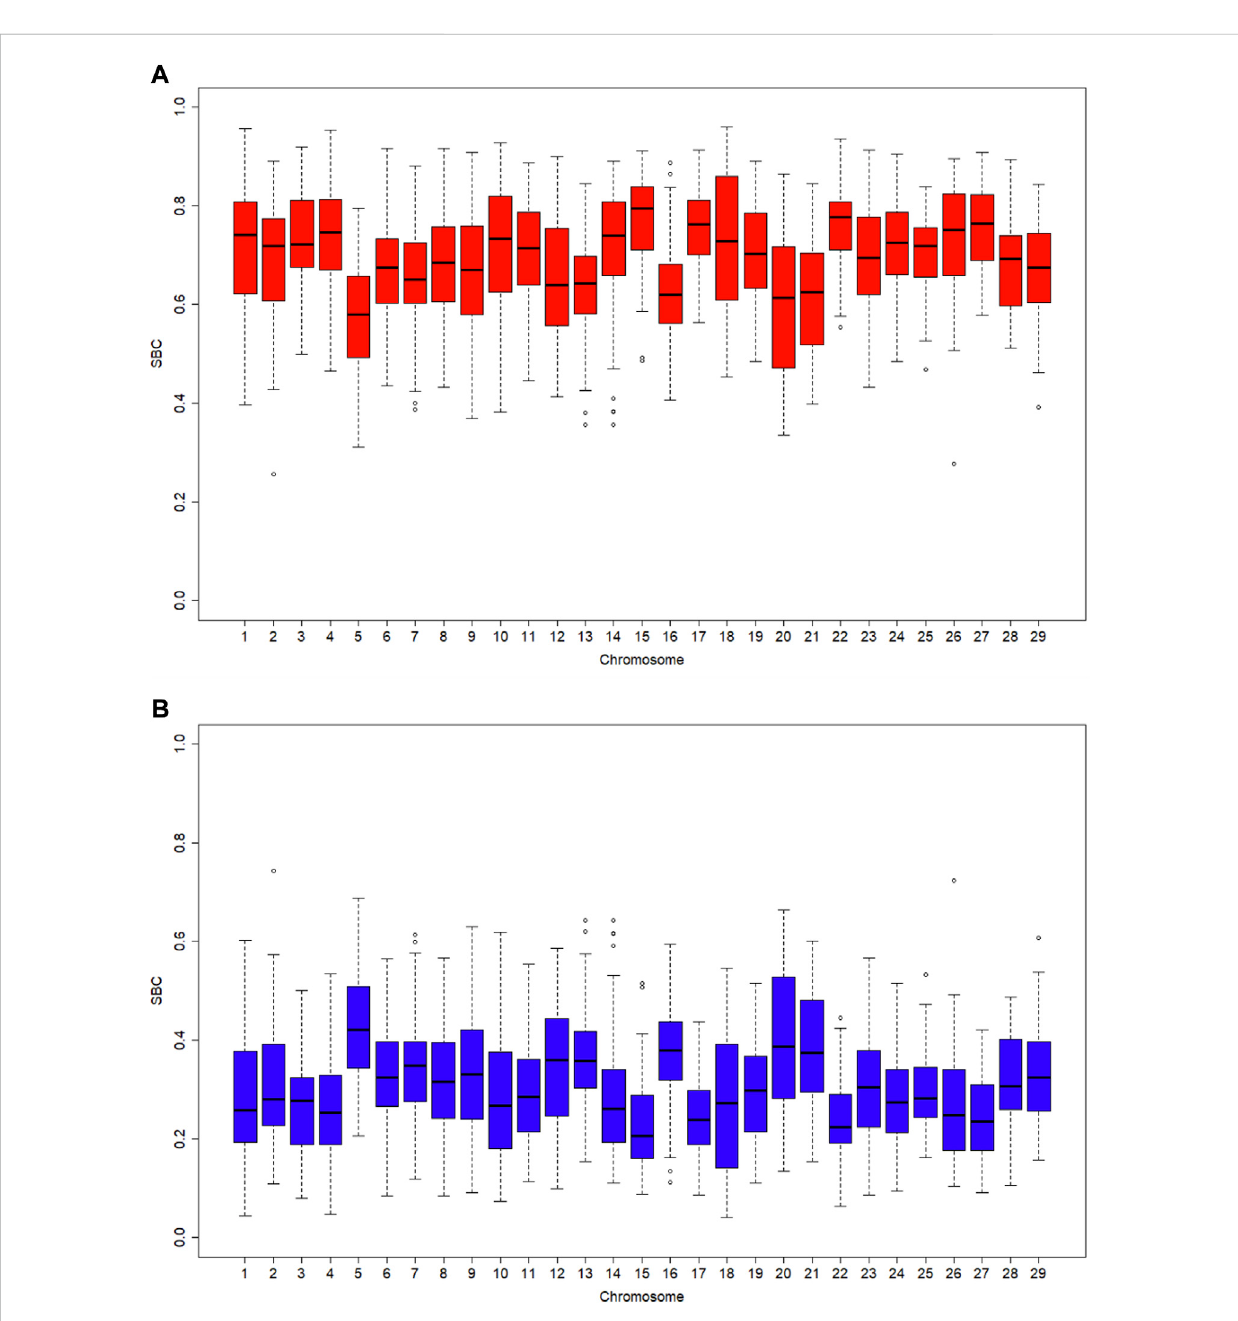
FIGURE 2 Boxplots of segmental-estimated breed compositions (SBC) for 3,605 Brangus cattle with the window size being 1 Mb on each chromosome: (A) Angus breed proportion; (B) Brahman breed proportion.